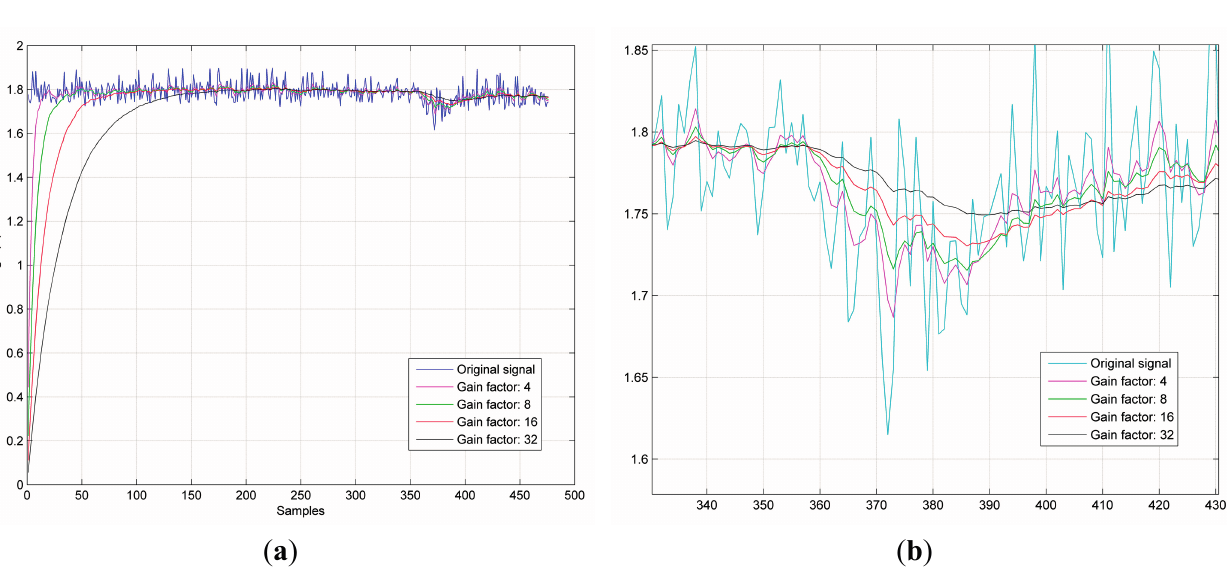
Figure 6. GF effects on ( a ) the filter lag and ( b ) the filter